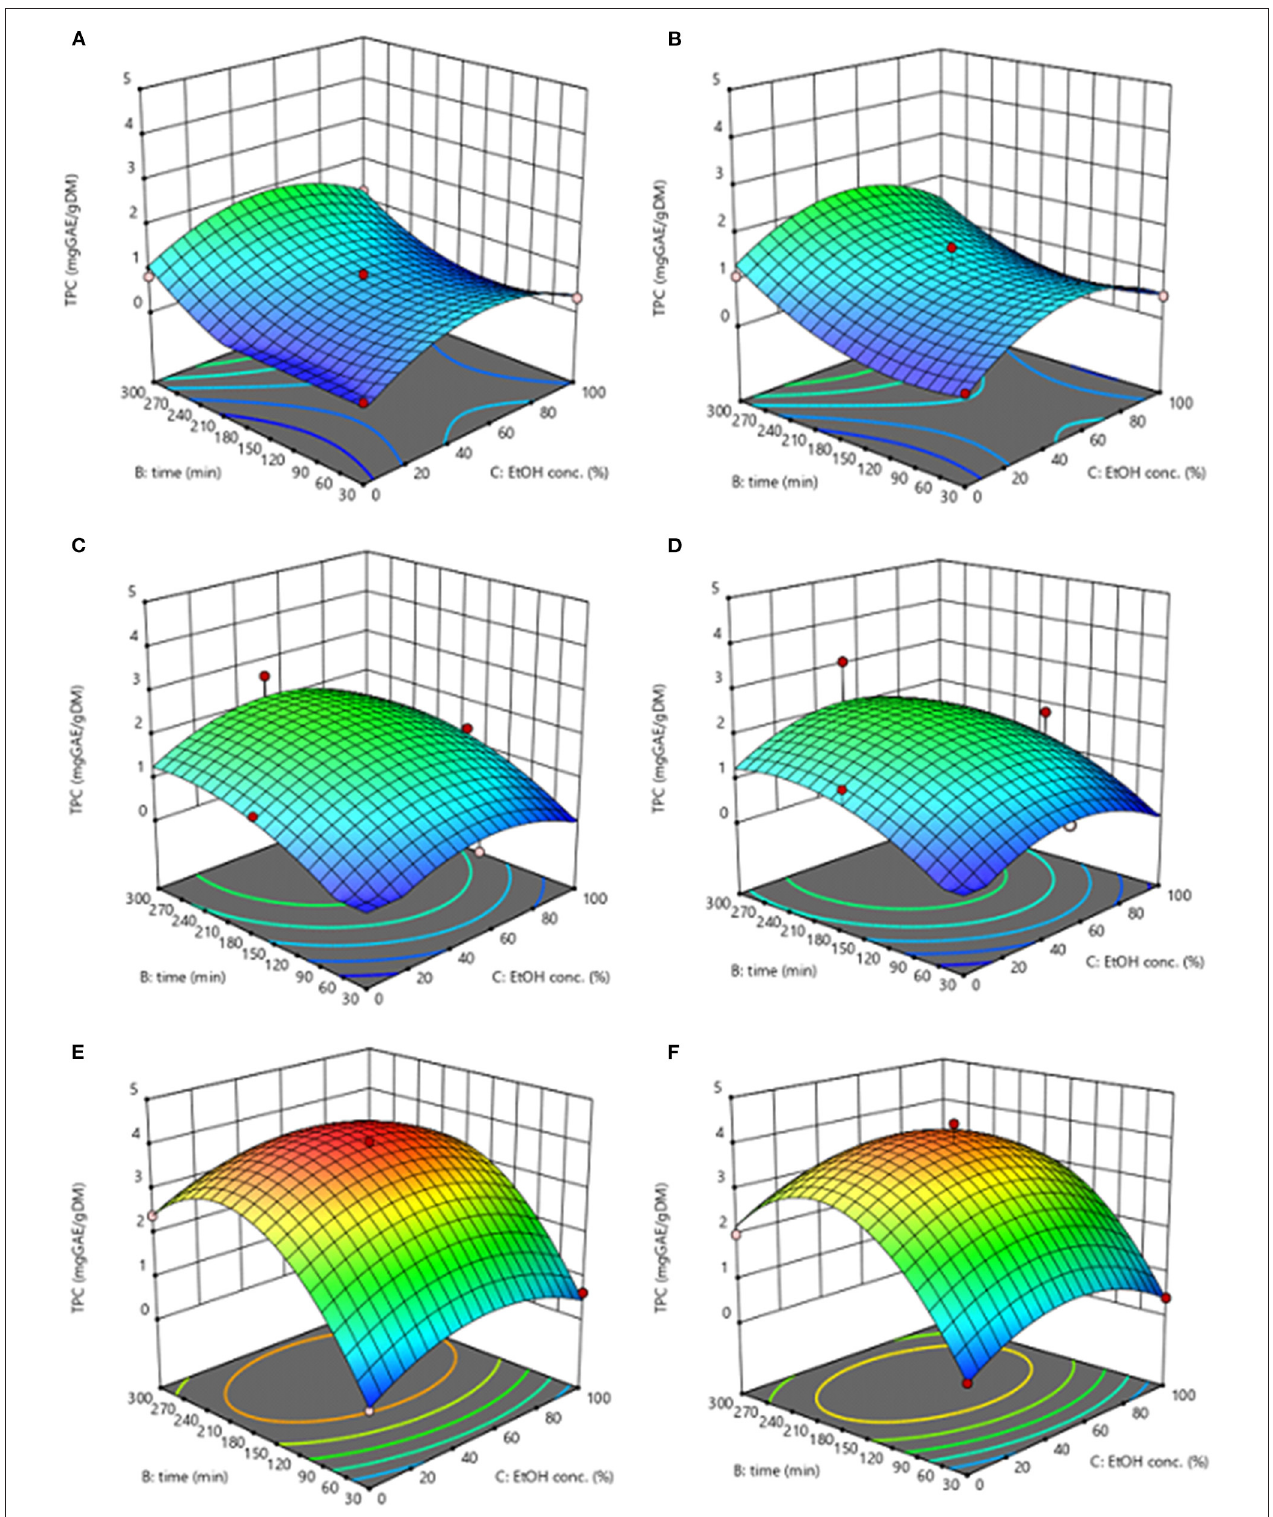
FIGURE 2 | Response surfaces for TPC of extracts obtained from untreated (Control) (A,C,E) and PEF-treated (E = 3.8 kV/cm; W T = 10kJ/kg) (B,D,F) grape pomace as a function of extraction time and ethanol concentration, with the extraction temperature set at 20 ◦ C (A,B) , 35 ◦ C (C,D) , 50 ◦ C (E,F) as extraction temperature.